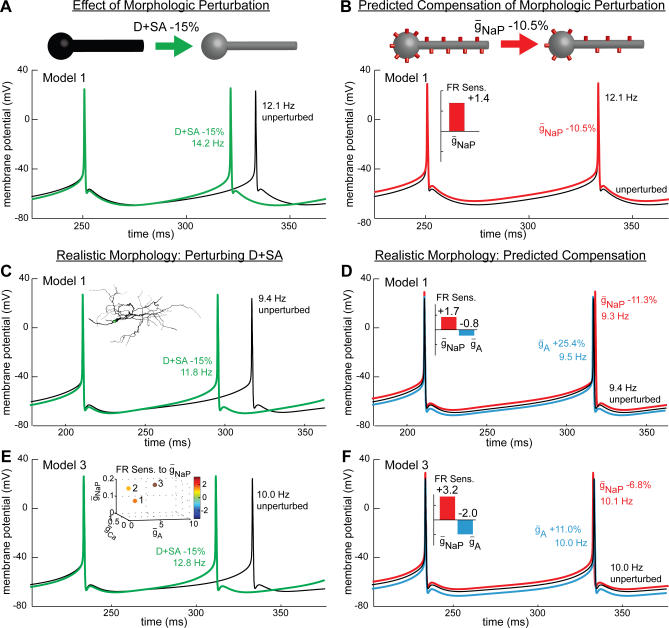
Using Sensitivities To Predict Parameter Compensations for Firing Rate Homeostasis in the Reduced and Realistic Morphologies(A–B) Parameter perturbations of Model 1 from subspace E (Figure S5, and inset of [E] below).(A) A 15% reduction of D + SA increased firing rate to 14.2 Hz (thick green line) relative to the unperturbed model (12.1 Hz; thin black line); a 14.8% reduction is needed to return to the unperturbed firing rate.(B) As predicted from its firing rate sensitivity (inset barplot), a 10.5% decrease in
compensated almost exactly for the effect of the D + SA perturbation on firing rate in (A) (see Discussion for details). The red trace, shifted up slightly along the vertical axis for visualization, overlays the unperturbed voltage trace very closely.
(C–F) Homeostatic parameter compensations can also be predicted in models with realistic morphology.(C) When Model 1 from subspace E was simulated in the realistic AII morphology, a 15% reduction of D + SA increased firing rate by 20.3% relative to the unperturbed value.(D) The compensatory perturbations for Model 1 of two different active parameters (
in red, shifted vertically up;
in blue, shifted down) were predicted from their firing rate sensitivities (inset barplots). The blue and red compensated traces overlie the unperturbed (black) trace very closely, demonstrating excellent compensation.
(E–F) Compensatory perturbations predicted from sensitivities computed at a different point in parameter space: Model 3 of subspace E, implemented in the realistic morphology with an analogous 15% reduction of D + SA. Inset in E shows the location of Models 1, 2, and 3 in the [
,
,
] subspace (also see Figure S5A). For Model 3, firing rate sensitivities to
and
were about twice as large as for Model 1. Accordingly, the predicted magnitudes for Model 3 were about half of those for Model 1; compare (D) and (F). For both models, the close match of red (shifted up), blue (shifted down), and black traces demonstrate that the predicted perturbations of either active parameter compensated almost exactly for the effect of the D + SA reduction ([C] and [E]), even for large predicted increases of
. See Discussion for details.